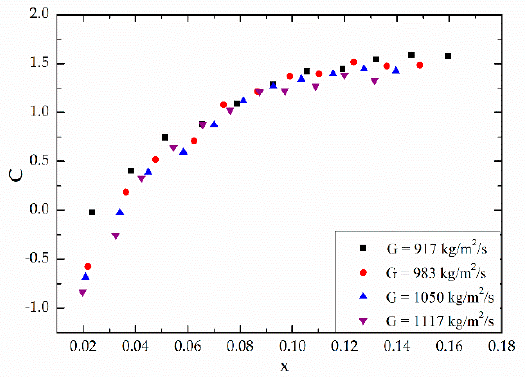
Figure 9. Variation of C under different mass velocities, versus local vapor quality, x, for q = 20.72 kW/m 2 .